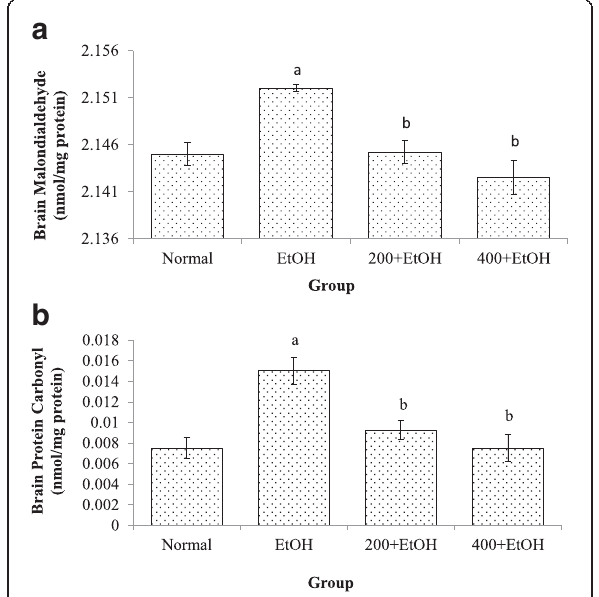
Fig. 1 a Effects of Z. zerumbet extract on malondialdehyde level. Values are expressed as mean ± SEM. “ a ” significant at F(5,18) = 16.978 p < 0.05 compared to normal group; “ b ” significant at p < 0.05 compared to ethanol group ( N = 6). (EtOH: ethanol; 200 + EtOH: 200 mg/kg extract + ethanol; 400 + EtOH: 400 mg/kg extract + ethanol). b Effects of Z. zerumbet extract on protein carbonyl level. Values are expressed as mean ± SEM. “ a ” significant at F(5,18) = 16.978 p < 0.05 compared to normal group; “ b ” significant at p < 0.05 compared to ethanol group ( N = 6). (EtOH: ethanol; 200 + EtOH: 200 mg/kg extract + ethanol; 400 + EtOH: 400 mg/kg extract